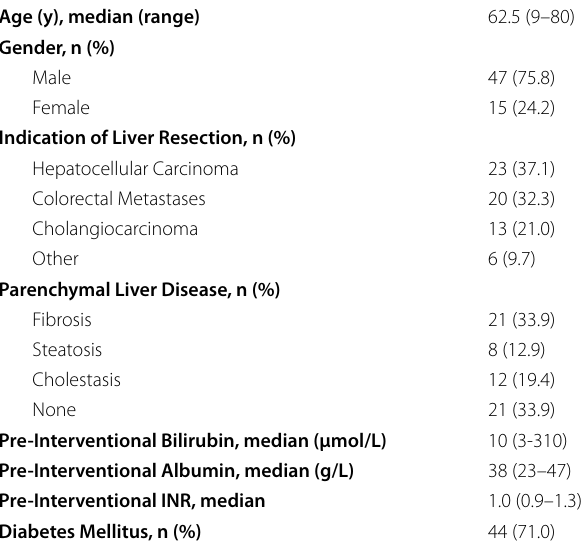
Table 1 Patient baseline characteristics Age (y), median (range)